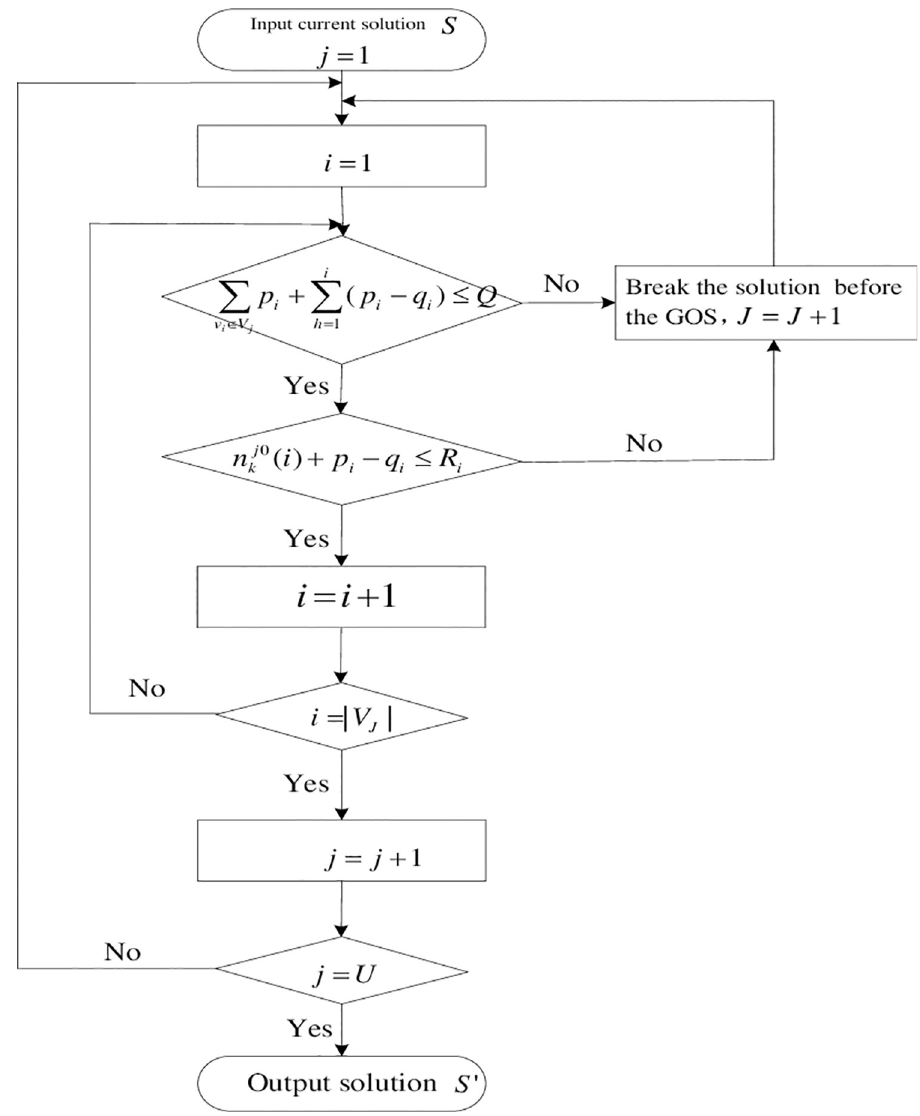
Fig 4. Flow chart of judging number of wagons for batch